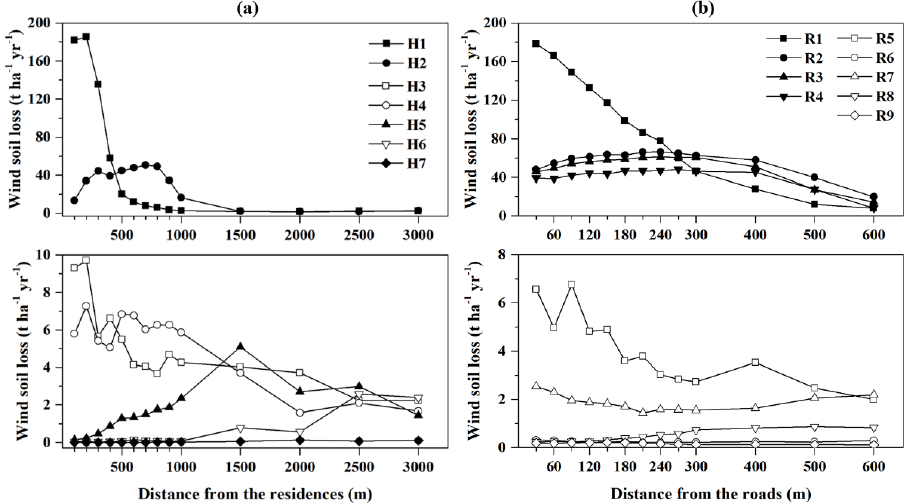
Figure 4. Variation in wind soil loss for individual representative residences (a) and roads (b) at different buffer distances.